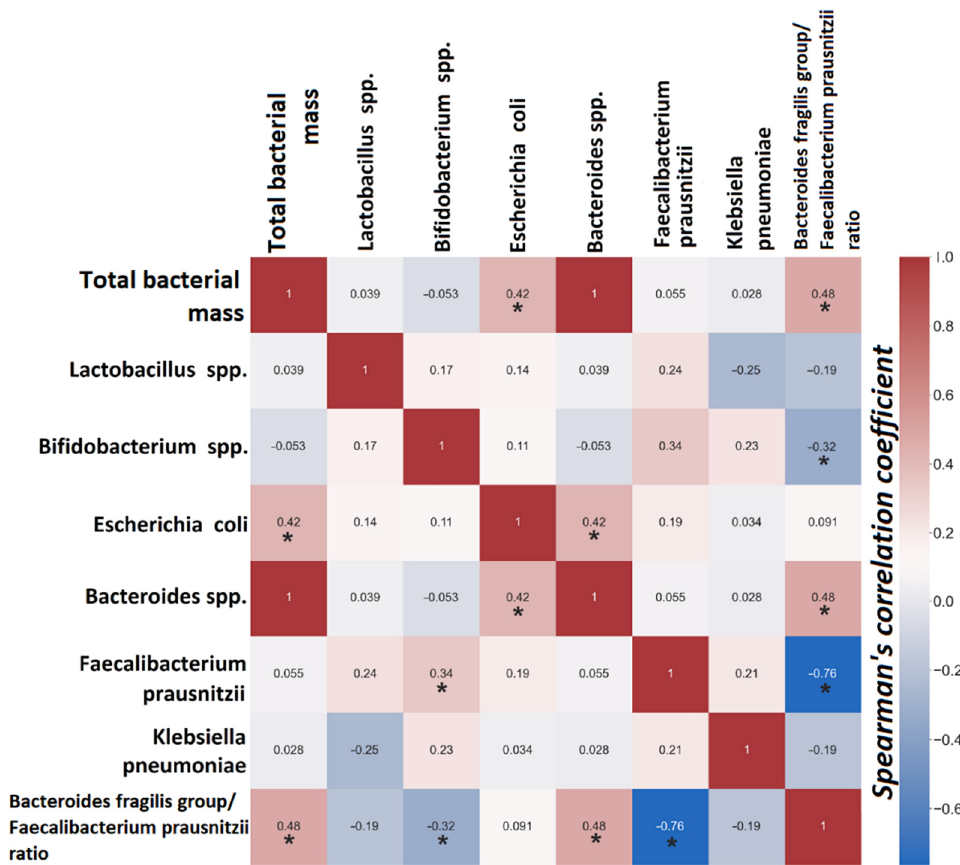
Figure 5. Heat map correlation relationships between microorganisms. Red squares are positive correlations, and blue are negative correlations. * Correlation is statistically significant.